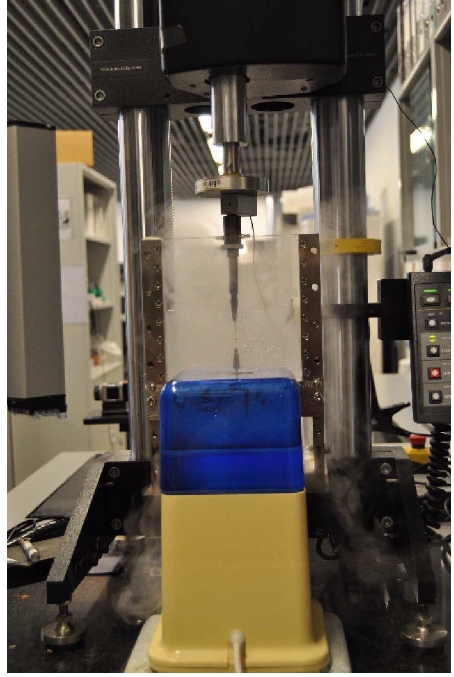
Figure 3. Experimental setup. Instron Microtester 5548 System with two clamps holding the sample. The samples are subjected to the tensile test under a humidity-controlled environment to prevent sample